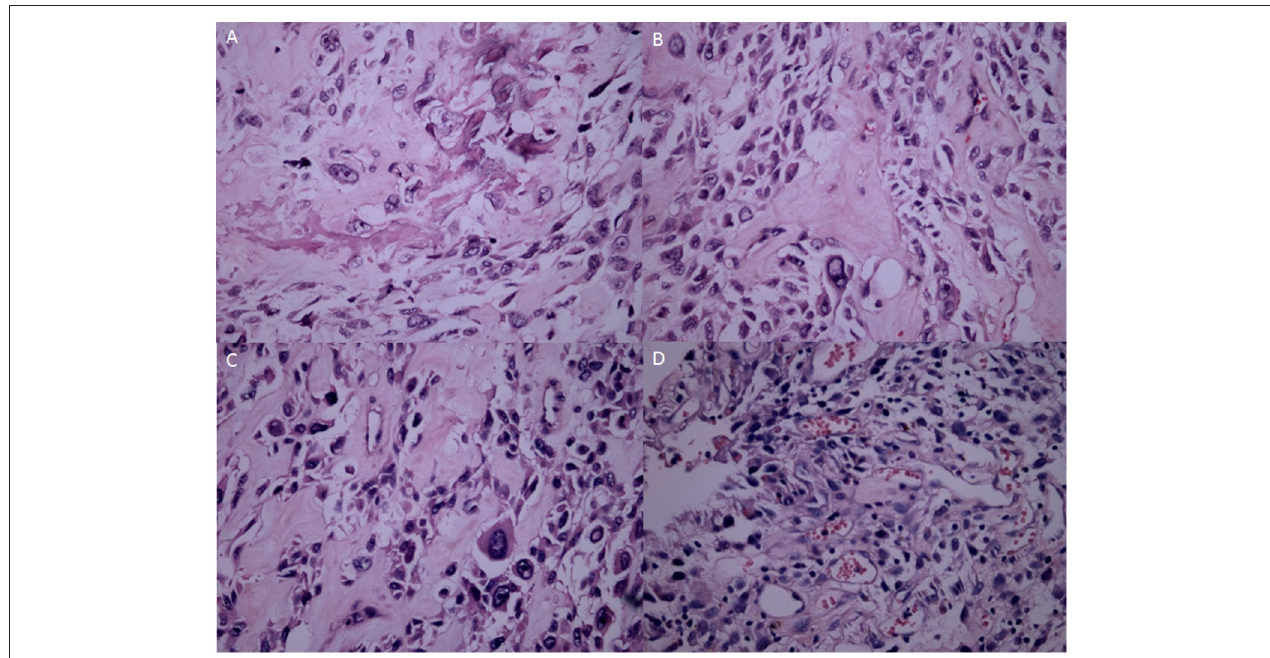
FIGURE 5 | H&E staining analysis of OS samples at different stages. (A) The OS consists of an atypical round to cell proliferation with osteoid deposition at G1 stage (H&E stain × 200). (B) OS cells shape variable with chromatic nuclei and mitosis fields at G2 stages. (C) Spindle cell neoplasm has high cellularity, abnormal mitotic characters and atypical nuclear at G3 stage. (D) The OS forms a highly-cancerous and high-mortality bone tumor at G4 stage.